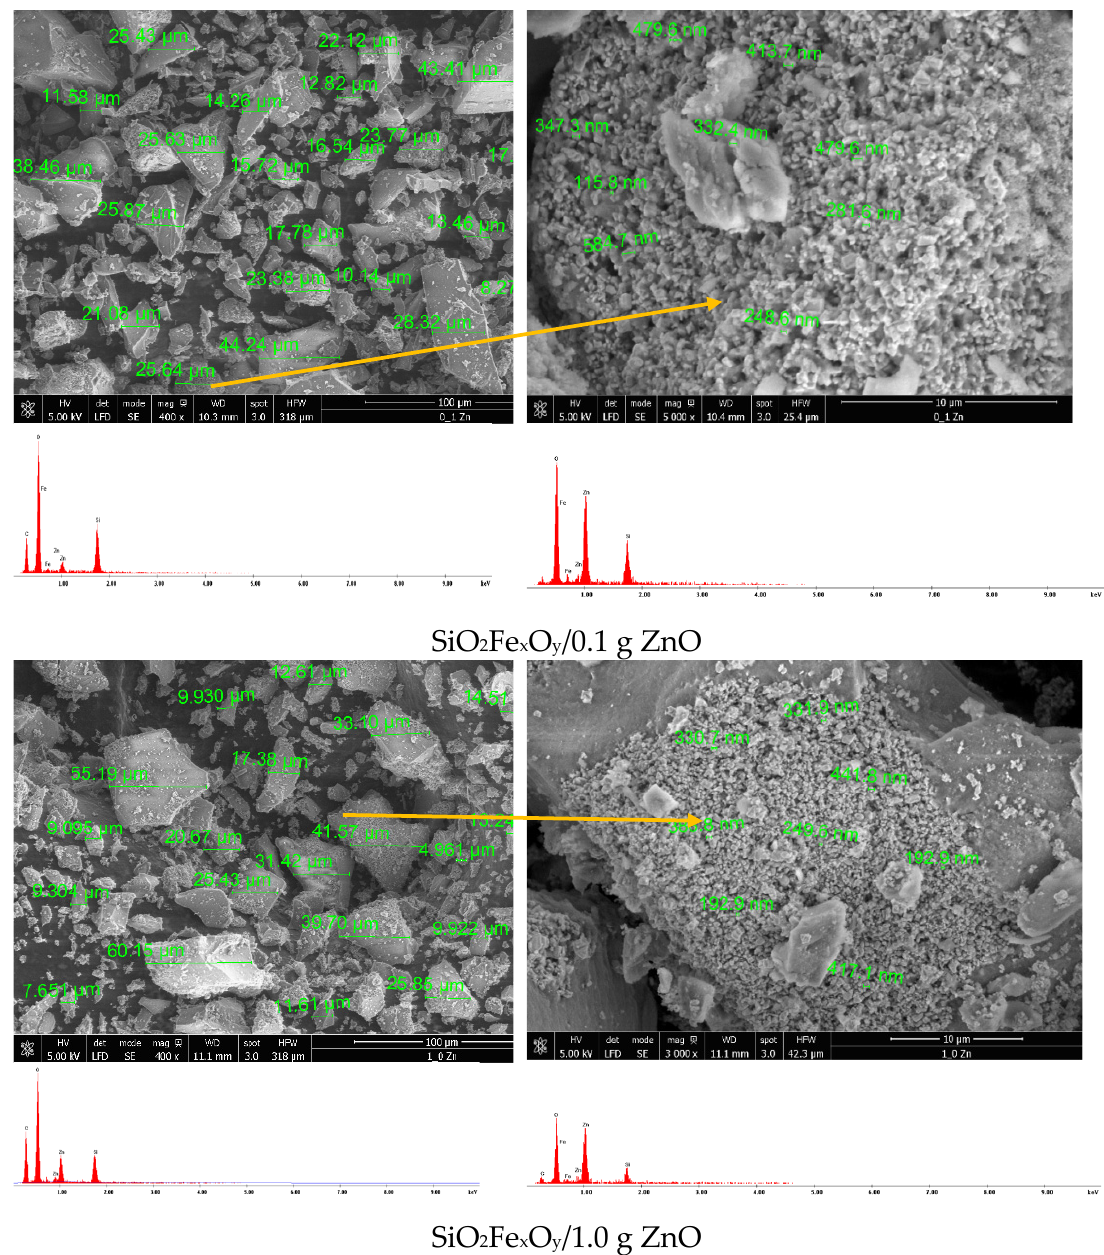
Figure 1. Scanning electron microscopy (SEM) and energy dispersive X-ray spectroscopy (EDX) for materials.